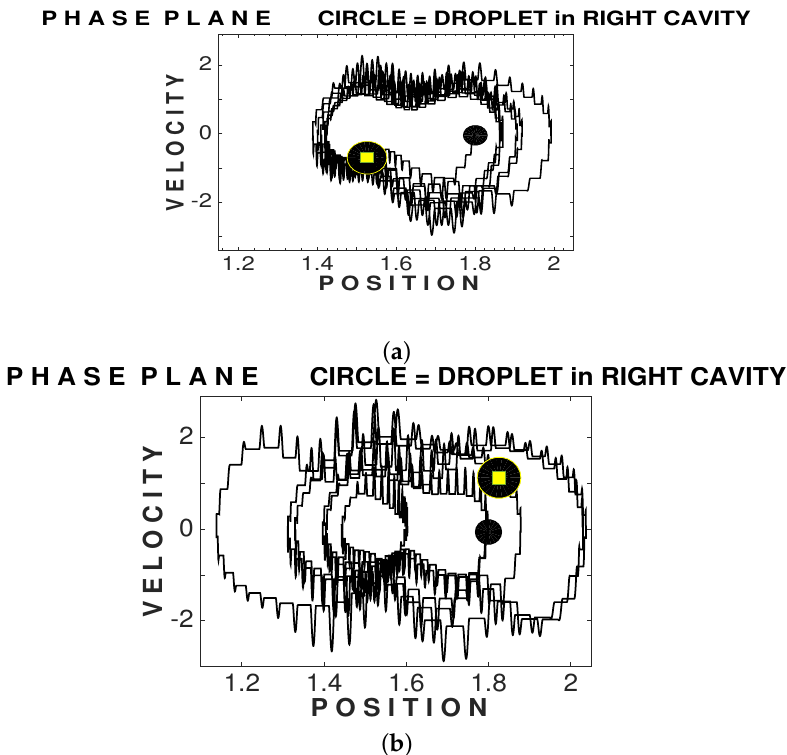
Figure 8. Phase plane dynamics for the simulations presented in Figure 7. The black dot shows the droplet’s starting position, while the dot with an inner square indicates its final position. ( a ) At the top: The droplet dynamics after the right-most barrier was lowered to having a fluid depth of 0.04 cm. The left barrier still had a fluid depth of 0.02 cm. The increased interaction with the mid-cavity is clearly seen through the appearance of cycles of different amplitudes. ( b ) At the bottom: The left-most barrier is also lowered to having a fluid depth of 0.04 cm above it. There is a small amount of wave activity in the left-most cavity which is enough to affect the oscillator in the right-most cavity far away. The phase space dynamics are much more